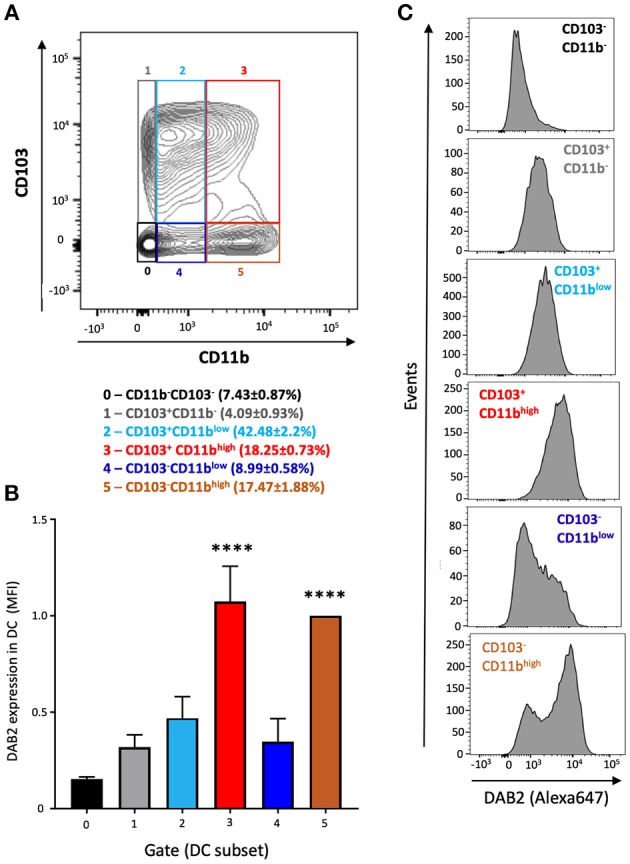
DAB2 is expressed in bone marrow derived dendritic cells from C57L/6J mice and correlates with CD11b expression. Bone-marrow derived dendritic cells (BMDCs) were differentiated from C57BL/6J mice with a combination of 200 ng/mL FLT3L for 9 days and 20 ng/mL GM-CSF for the last 2 days and analyzed by flow cytometry after staining with viability dye eFluor 506, anti-F480, B220, CD11c, CD11b, CD103, and anti-DAB2 mAbs. Conventional DC are depicted as live F480−B220−CD11c+ and stratified by CD11b and CD103 expression. (A) Relative abundance of BMDC phenotypes based on the expression of CD11b (neg, low, or high) and CD103 (neg, pos) (gates 0–5). (B) DAB2 expression in BMDCs is expressed as mean fluorescence intensity (MFI) in each gate. (C) Representative histograms of DAB2 expression in the populations gates as in (A). Data represent mean values of three independent experiments combined (n = 3 mice/experiment ****p < 0.001 when compared to the gates/populations 0, 1, 2, and 4).